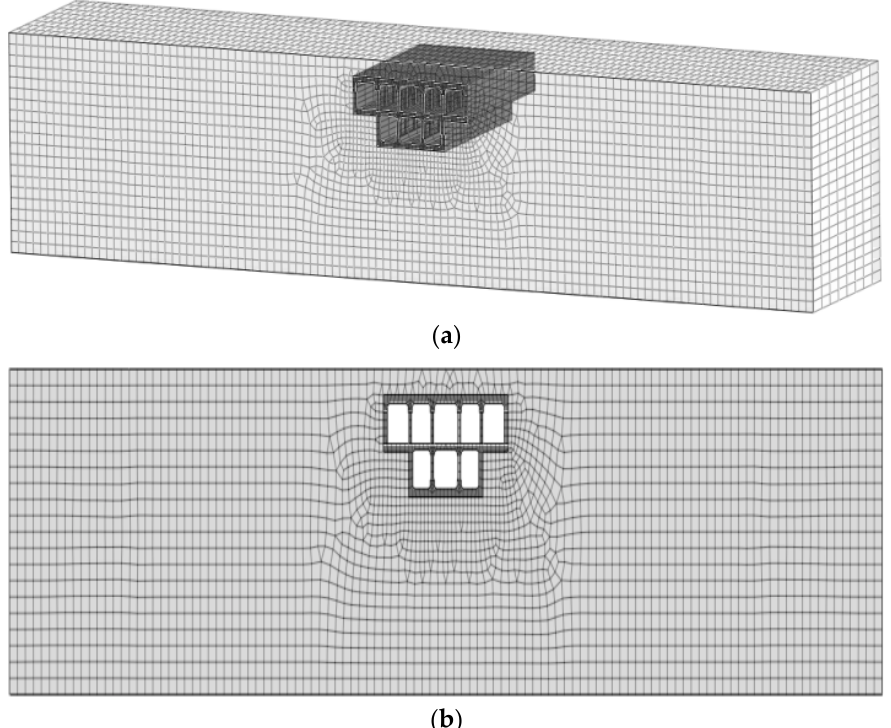
Figure 2. Cross-sectional view of the subway station structure (mm).